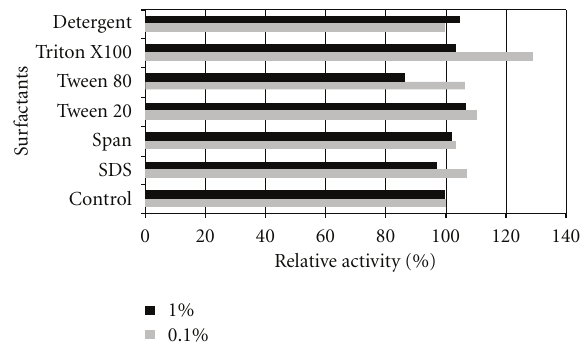
Figure 6: E ff ects of various surfactants on Acinetobacter sp. lipase activity. The enzyme was preincubated for 30min at 30 ◦ C with 0.1 and 1% (v/v) of each nonionic surfactants and commercial detergent; 1 and 5mM SDS (ionic surfactant) in phosphate bu ff er (50mM, pH 7.0). The lipolytic activity was measured at 65 ◦ C relative to the control (without surfactant), using olive oil (emulsified, 1:1 v/v, in 50mM Tris-HCl bu ff er, pH 8.0) as